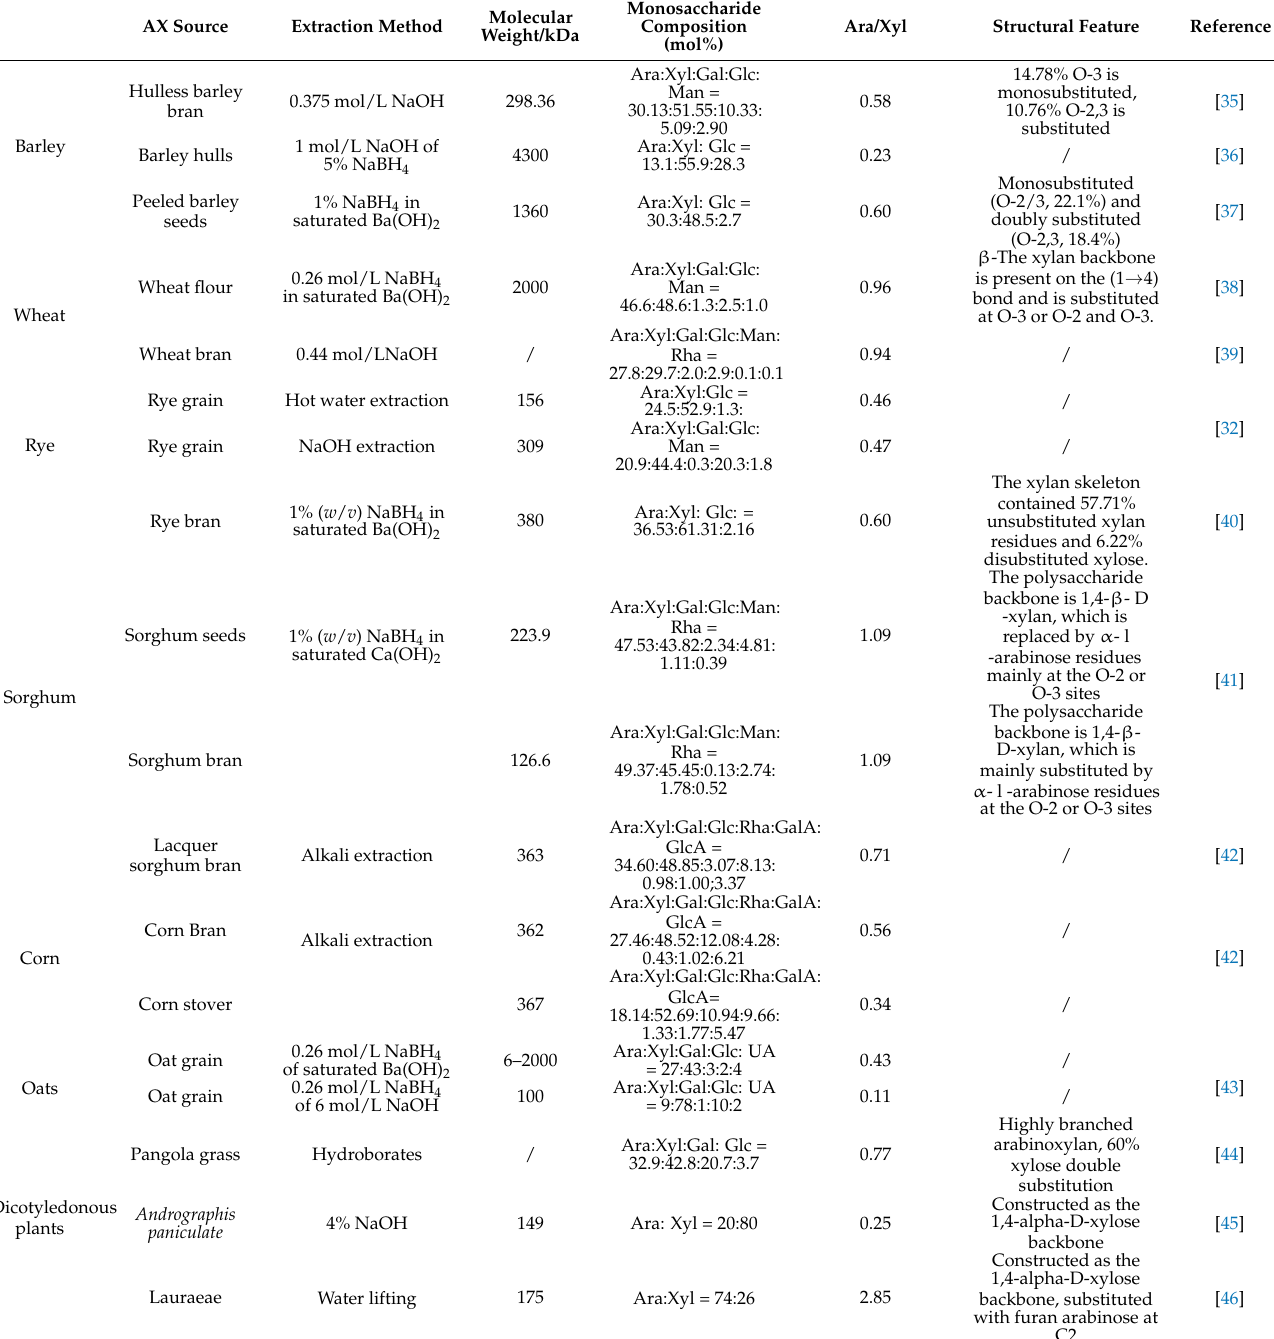
Table 1. Molecular characterization of AX from different